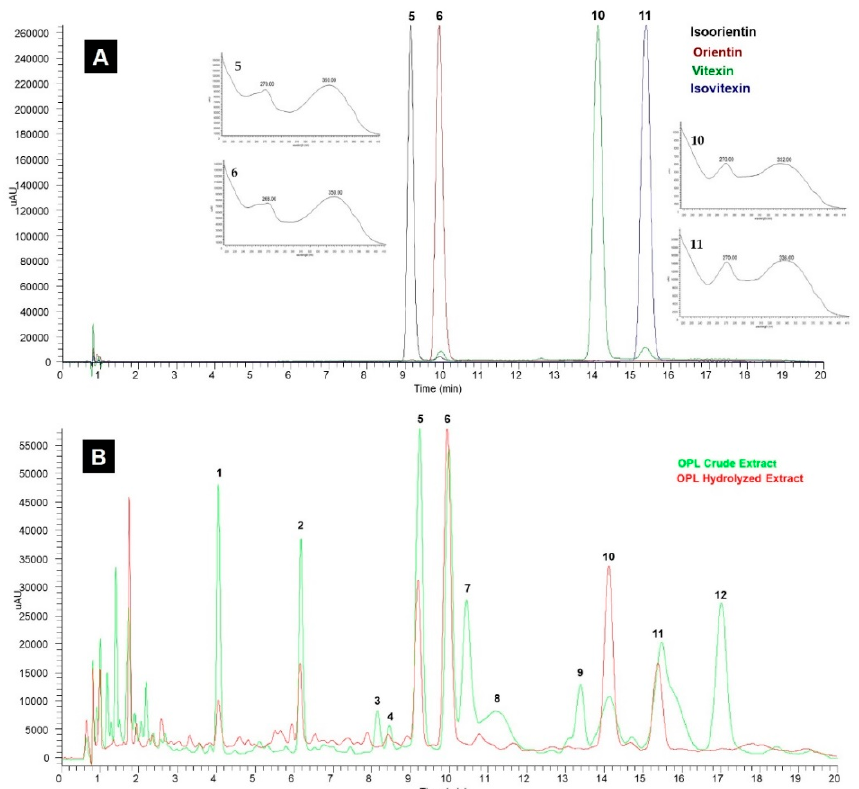
Figure 2. ( A ) Ultra-high-performance liquid chromatography-ultraviolet/photo-diode array (UHPLC-UV/PDA) chromatogram of commercial standards recorded at 340 nm: 5 , isoorientin; 6 , orientin; 10 , vitexin; and 11 , isovitexin. ( B ) Typical chromatogram of OPL crude and hydrolyzed extracts at 340 nm. Peak identified: 1 , luteolin-6,8-di- C -hexose (Isomer 1); 2 , apigenin-6,8-di- C -hexose; 3 , luteolin-6,8-di- C -hexose (Isomer 2); 4 , apigenin-6- C -pentose-8- C -hexose (Isomer 1); 5 , isoorientin; 6 , orientin; 7 , luteolin-6- C -hexose-8- C -deoxyhexose (Isomer 1); 8 , apigenin-6- C -pentose-8- C -hexose (Isomer 2); 9 , luteolin-6- C -hexose-8- C -deoxyhexose (Isomer 2); 10 , vitexin; 11 , isovitexin; and 12 , apigenin-6- C -hexose-8- C -deoxyhexose. Table 1. Linearity, LOD, and LOQ of isoorientin, orientin, vitexin, and isovitexin. Concentration Regression Flavonoid Range Equation ( µ g/mL)